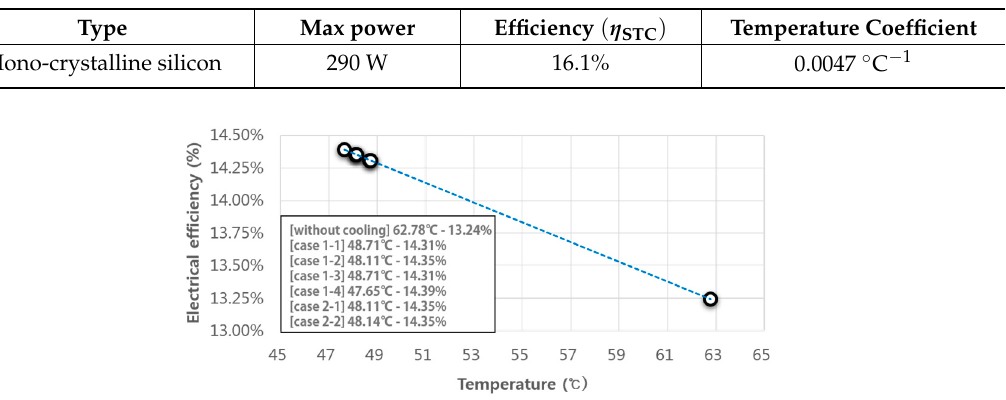
Figure 15. Variation of electrical efficiency as a function of PV temperature.